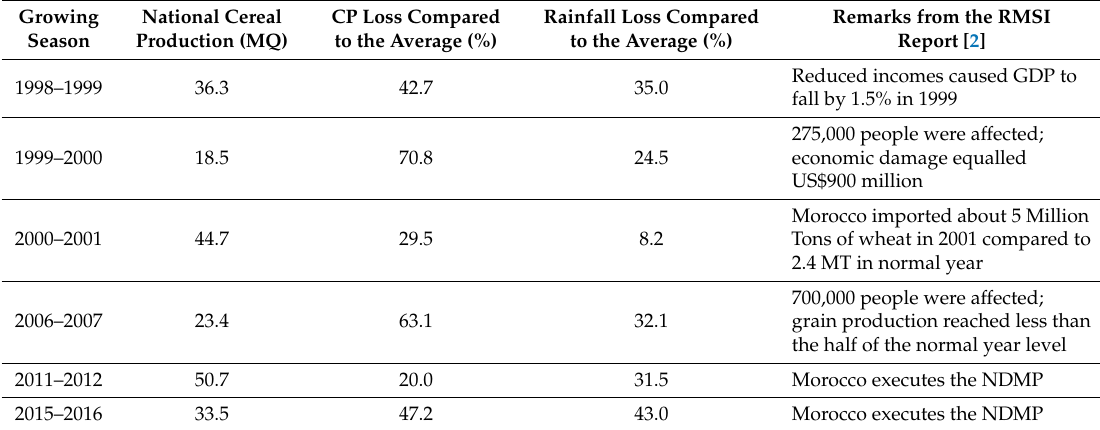
Table 1. Socio-economic impacts of recent droughts in